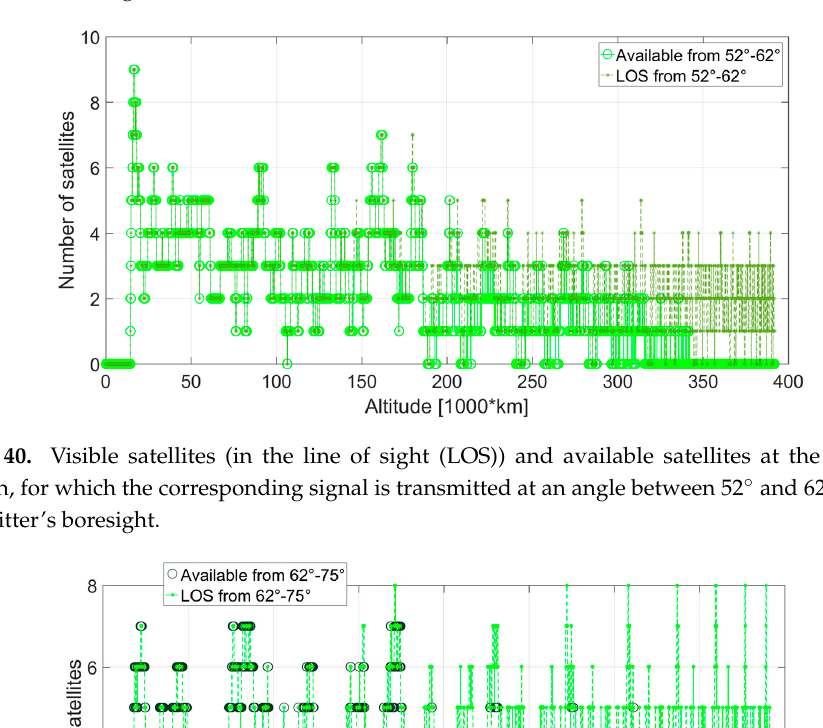
Figure 39. Visible satellites (in the line of sight (LOS)) and available satellites at the receiver’s position, for which the corresponding signal is transmitted at an angle between 37° and 52° from the transmitter’s boresight.